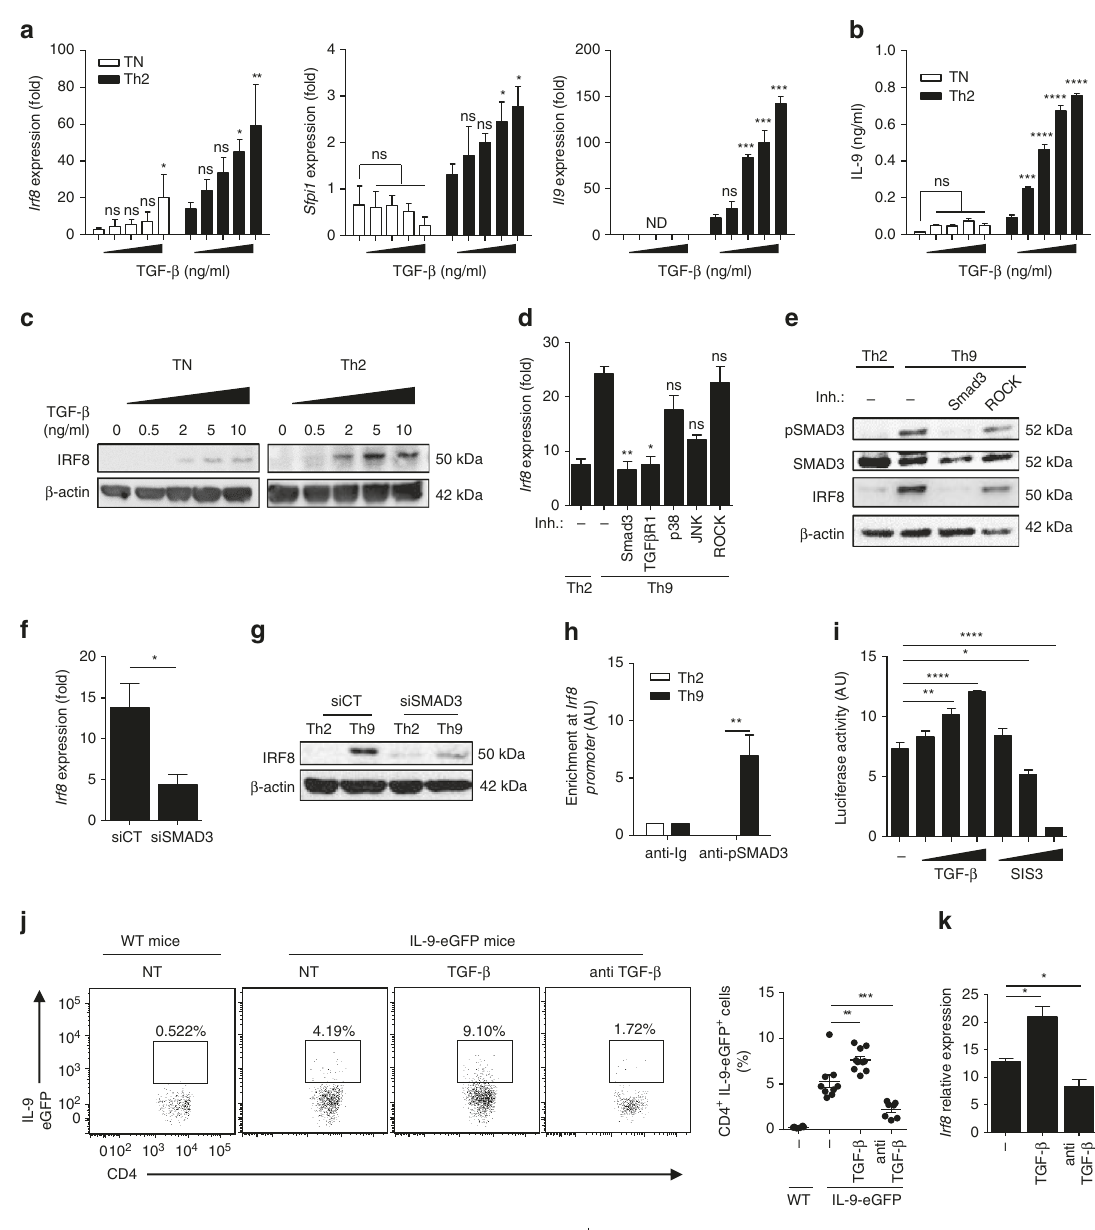
Fig. 2 IRF8 is induced through the SMAD3/TGF- β pathway. a – c WT naive CD4 + cells (TN) without stimulation or Th2 cells were treated with increasing doses of TGF- β (0, 0.5, 2, 5 and 10 ng/ml). Irf8, Sfpi1 and Il9 mRNA expression after 16 h of treatment ( a ). ELISA analysis of IL-9 in supernatant after 3 days ( b ). Immunoblot analysis of IRF8 after 16 h of treatment ( c ). d , e WT naive CD4 + T cells (TN) were treated 1 h with pharmacological inhibitors against TGF- β signalling pathways (TGF- β R1, SMAD3, p38, ROCK, JNK). Cells were then polarised under Th9 conditions. Irf8 mRNA expression in Th2 and Th9 cells or cells or in Th9 cells treated with SMAD3 or ROCK inhibitor after 24 h of treatment ( e ). f , g WT naive CD4 + T cells were transfected with siCT or